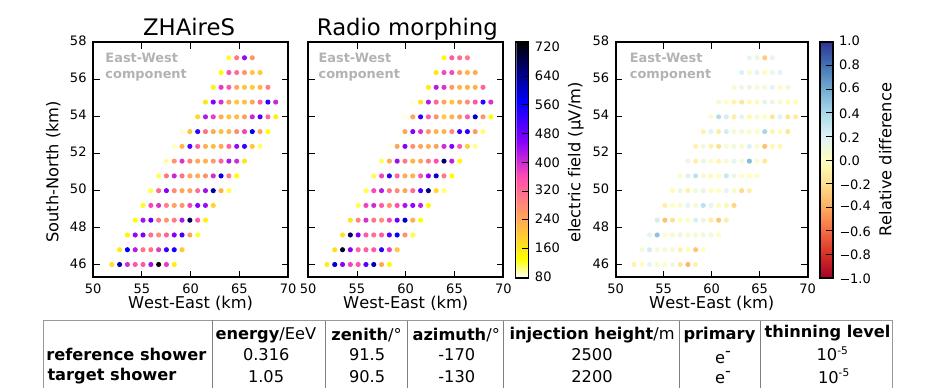
Figure 1. Top: Comparison of a ZHAireS simulation (left) and Radio Morphing (center). Right: Relative di ff erence between the peak-to-peak amplitudes at each observer position defined as ( E zhaires Bottom: Table of primary’s parameters for the reference and target